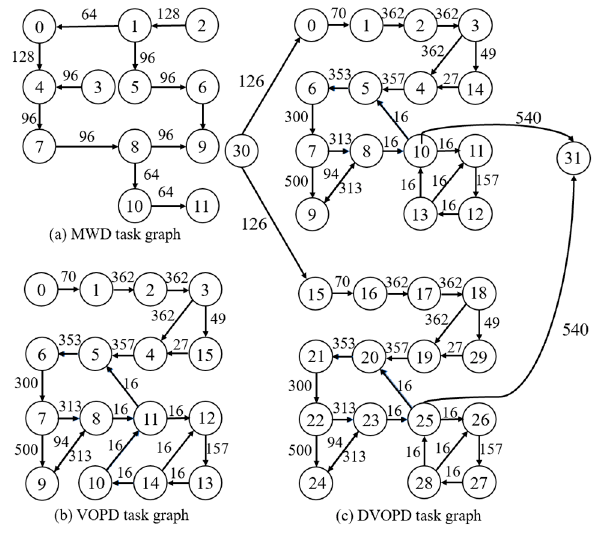
Figure 3. Classic Task Graph.